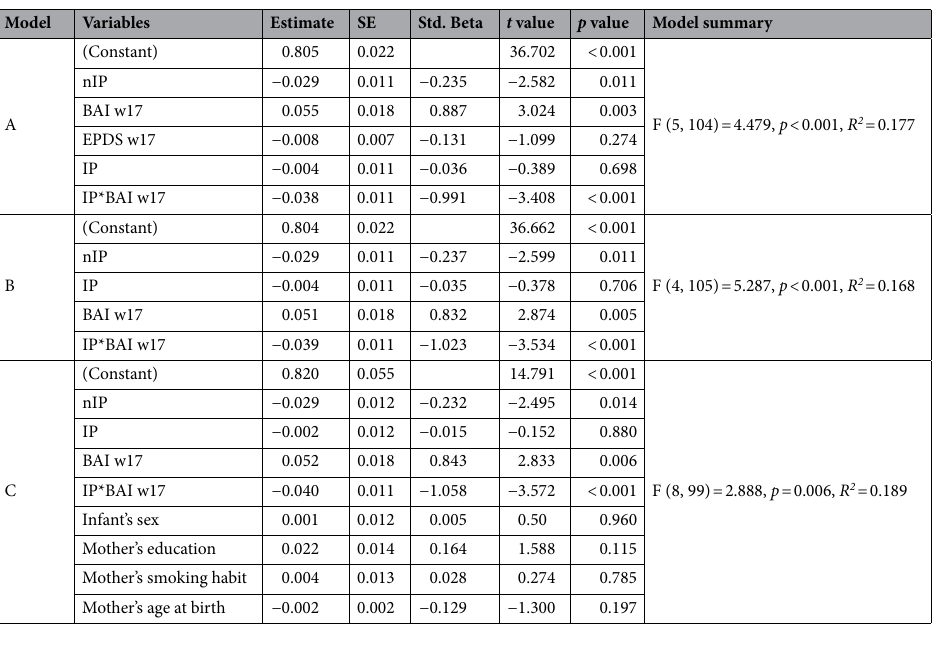
Table 1. The final multivariate linear model with infants’ look percentage as an outcome measure. Model A includes all significant variables united from Table 2. Model B uses the backward stepwise method to eliminate variables and improve the model. Model C is the final model after adjusting for infant sex, mother’s education, smoking habit, and the mother’s age birth. SE, Standardized Error; Std. Beta, Standardized Beta; EPDS, Edinburgh Postnatal Depression Scale; BAI, Beck Anxiety Inventory; w17, pregnancy week 17; w32, pregnancy week 32; pv6, postpartum 6 weeks; pm6, postpartum 6 months; IP, interpersonal events; nIP, non-interpersonal events.